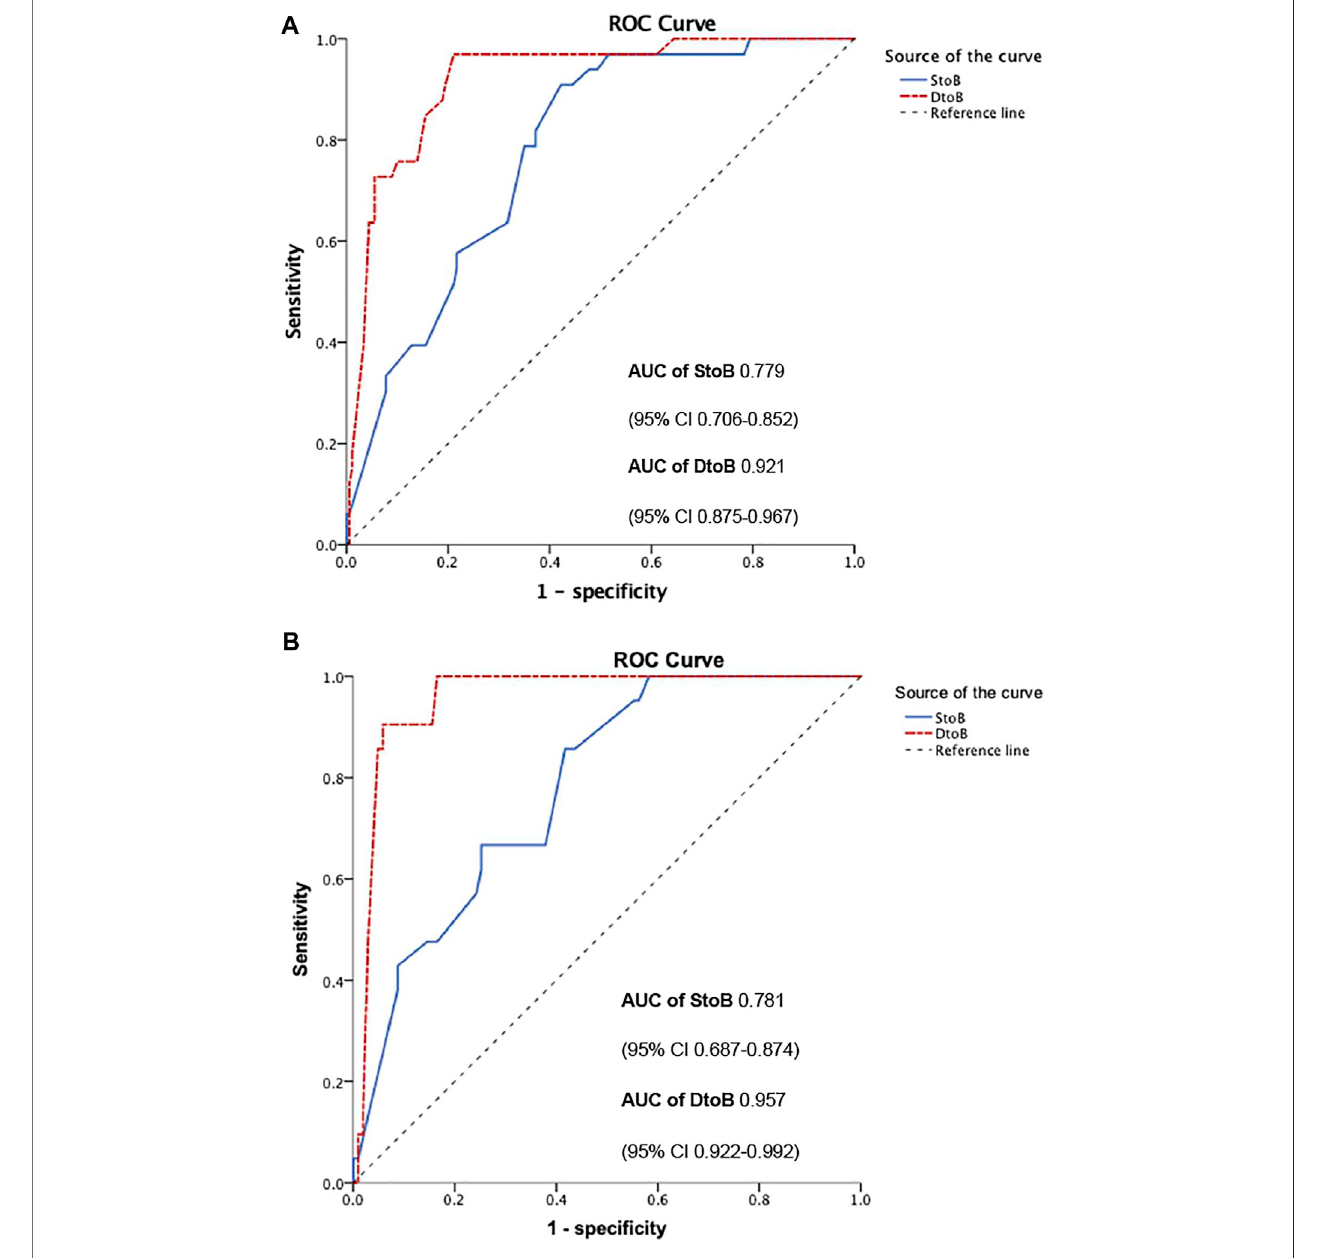
FIGURE 5 | ROC curve of STOB and DTOB predicting MACEs before (A) and after (B) propensity score matching. Abbreviations: S to B, time from symptom to balloon; D to B, time from door to balloon; ROC, Receiver Operating characteristic; AUC, Area under curve.